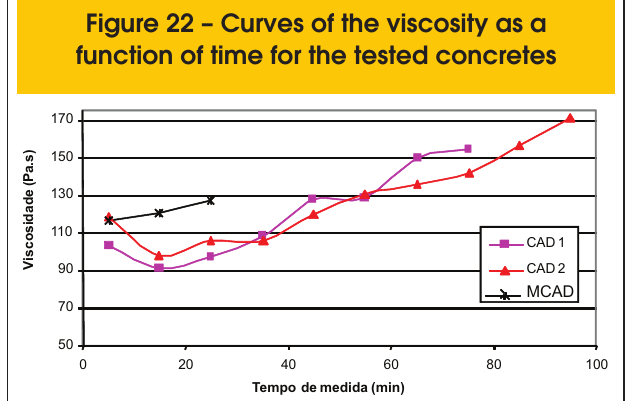
Figure 22 – Curves of the viscosity as a function of time for the tested